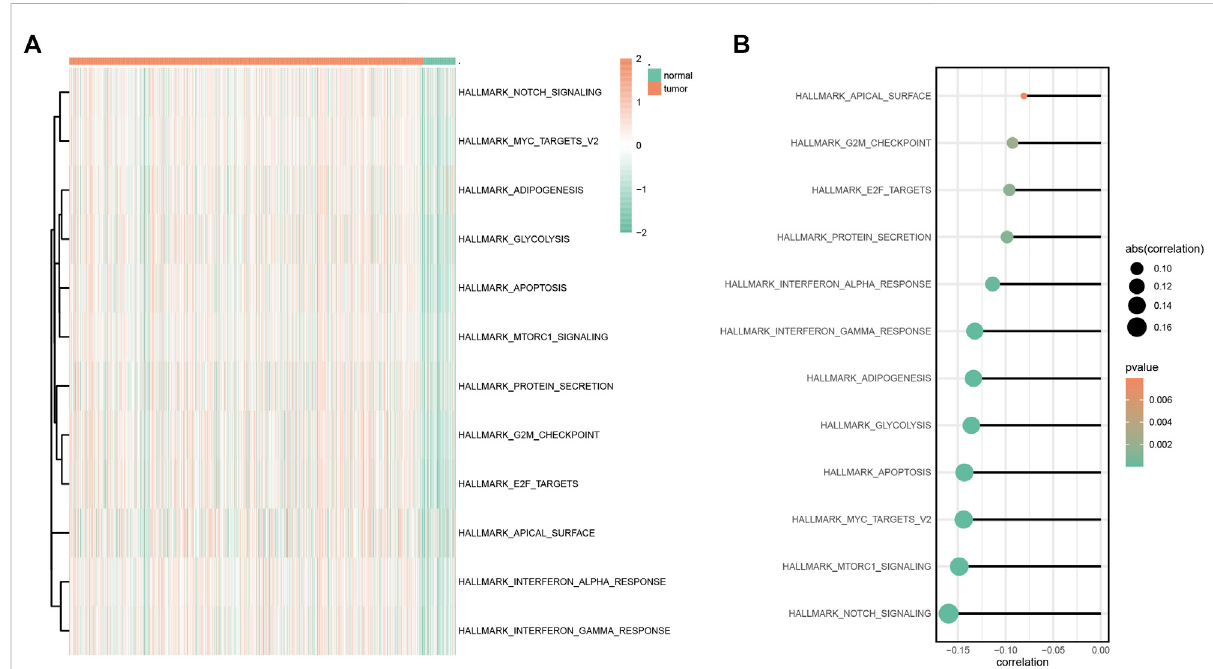
FIGURE 6 GSVA analysis. (A) Heatmap of GSVA differential pathway results based on the hallmark gene set. (B) Correlation analysis between differential pathway and the SYCP2 expression